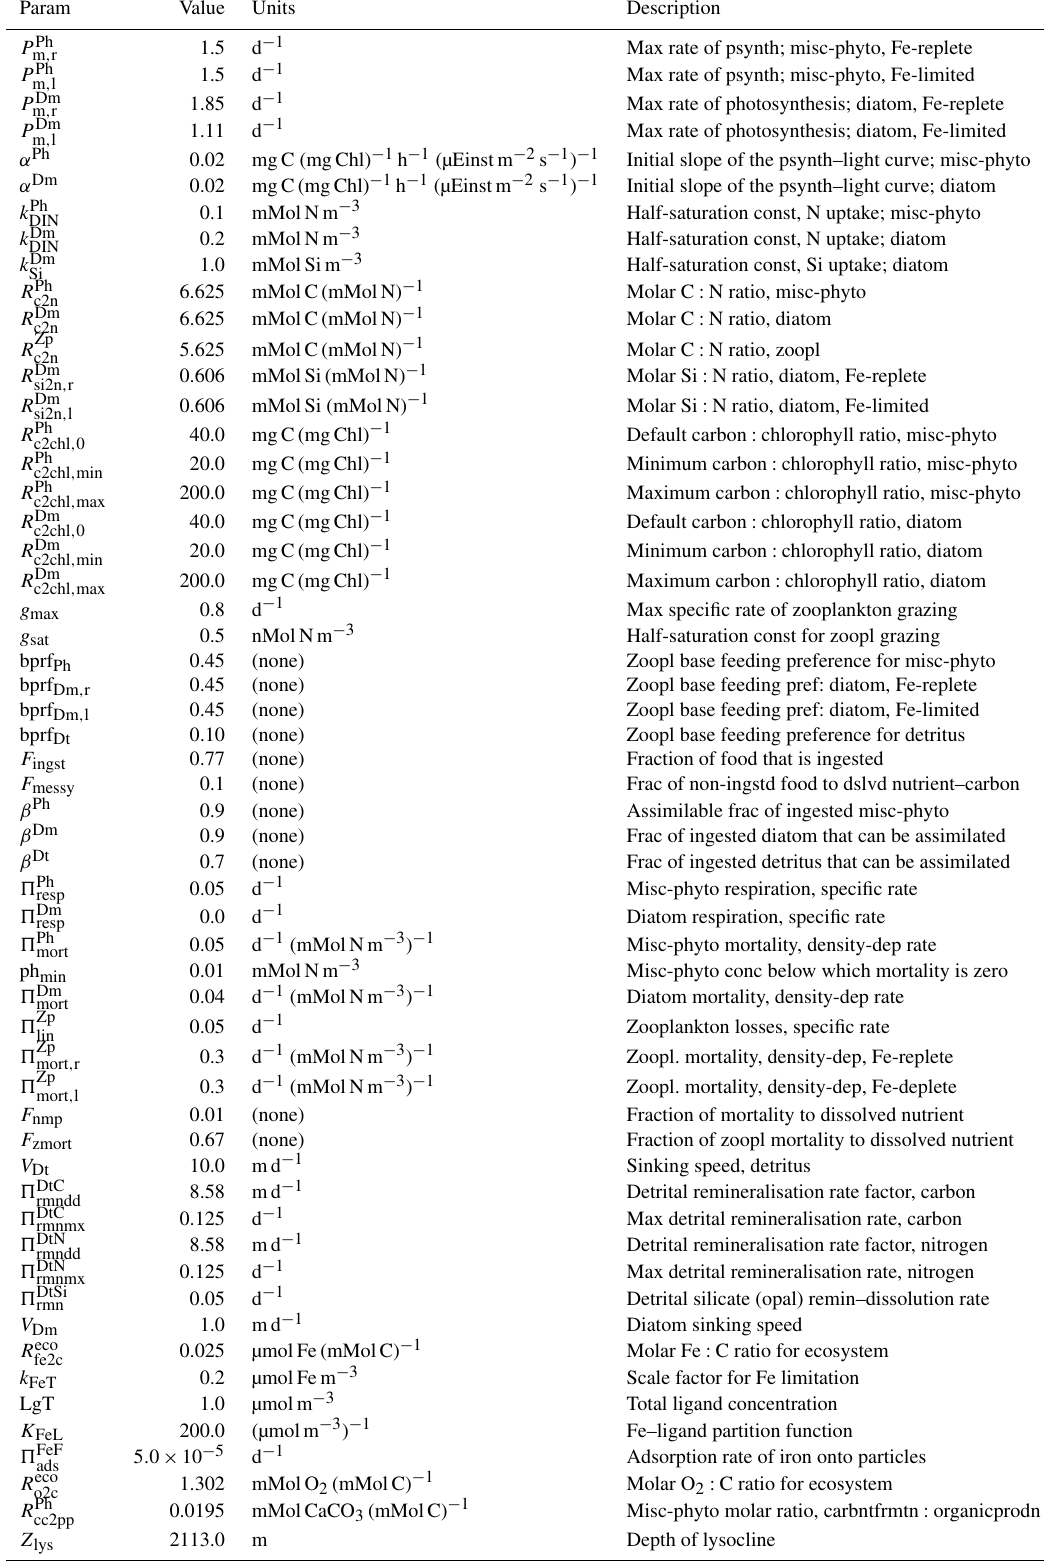
Table B1. Parameter values used in CMIP5 simulations.